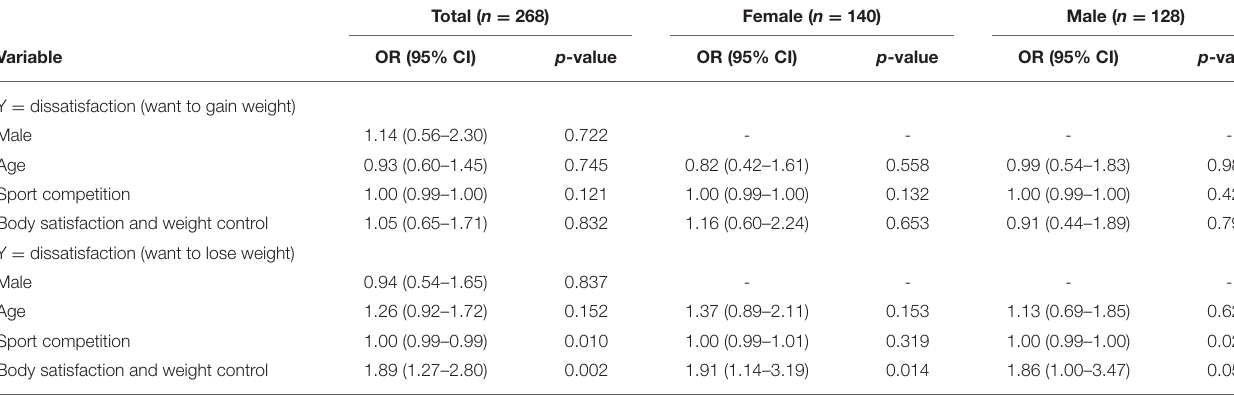
TABLE 4 | Multinomial logistic regression models predicting body image (dis)satisfaction.